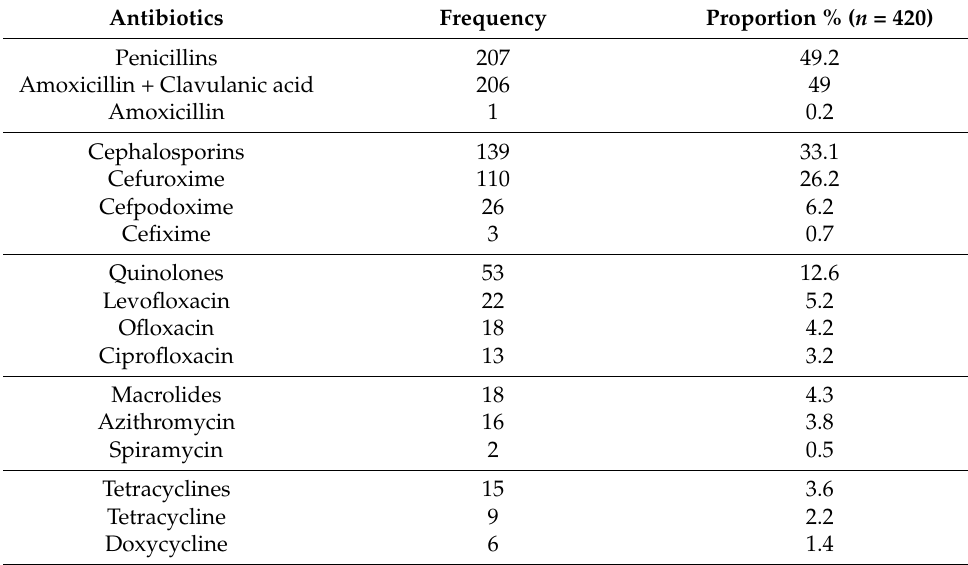
Table A2. Frequency of prescribed